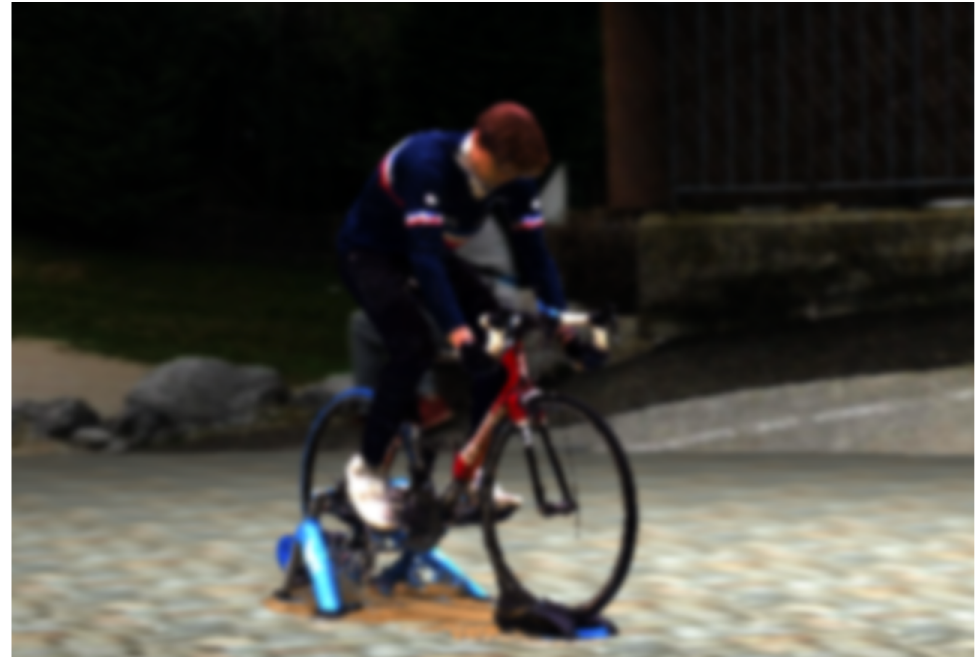
Figure 5. The image under poor image quality (Im) conditions. A Gaussian blur (11 × 11 px) was applied, and a 0.5 gamma compression made the image darker. applied, and a 0.5 gamma compression made the image